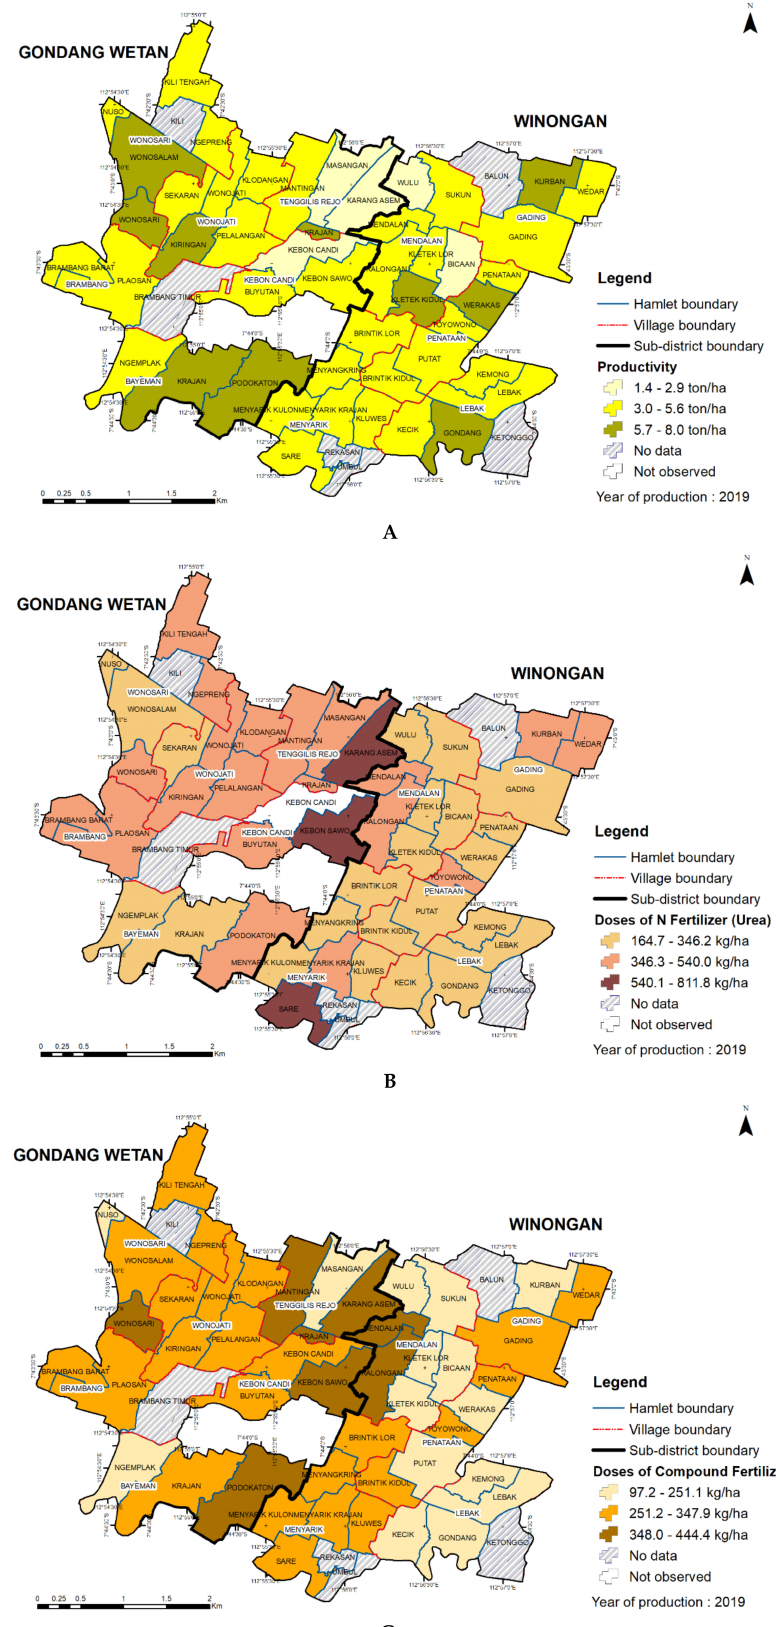
Figure 9. Spatial distribution of rice yield ( A ), urea application ( B ), and compound fertiliser ( C ) at hamlet